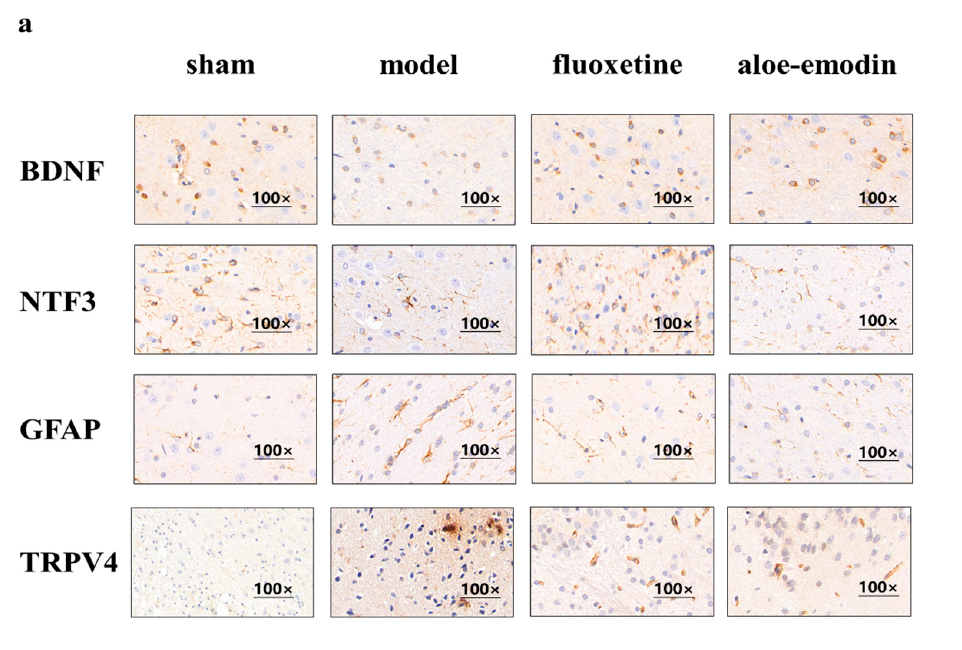
Figure 4. ( a ) Immunohistochemical detection of the expressions of BDNF, NTF3, GFAP, and TRPV4 in brain tissue; ( b ) quantitative analysis of immunohistochemical staining (n = 3); ( c ) Western blot detection of BDNF, NTF3, GFAP, and TRPV4 protein expressions in brain tissue; and ( d ) quantita- tive analysis of Western blot detection of BDNF, NTF3, GFAP, and TRPV4 protein expressions in brain tissue (n = 3). (** p < 0.01) (* p < 0.05). 2.6. Western Blot Western blot (WB) can be used to detect protein expression in the brain tissue of rats with PSD. As shown in Figure 3c,d, the protein expression of AQP3, AQP4, and AQP5 in the brain tissue of the rats in each treatment group is decreased compared to the model